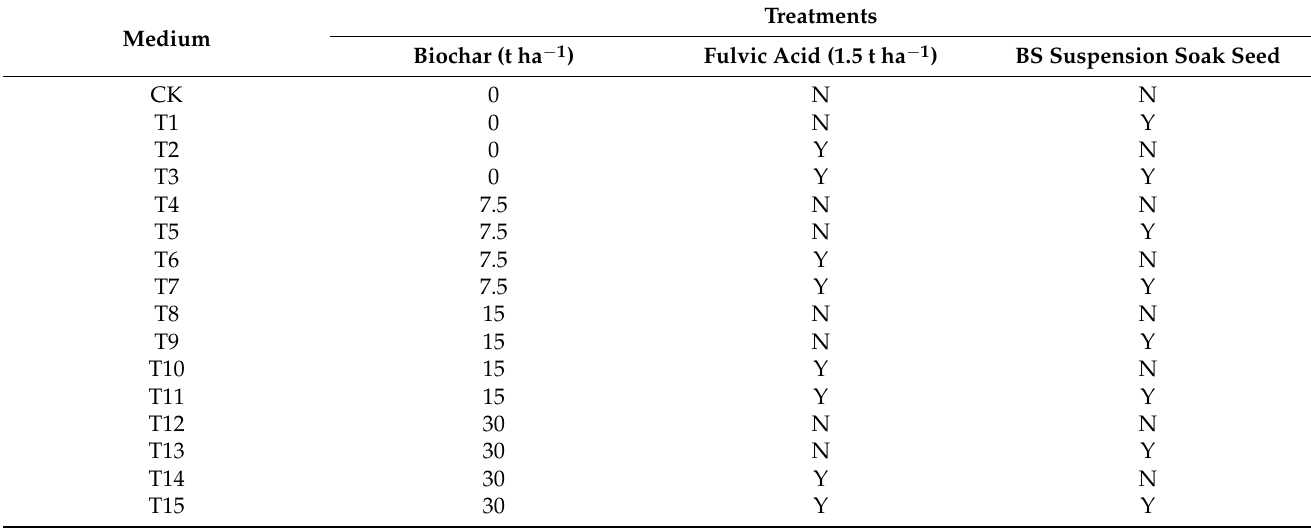
Table 1. The experimental treatments and their